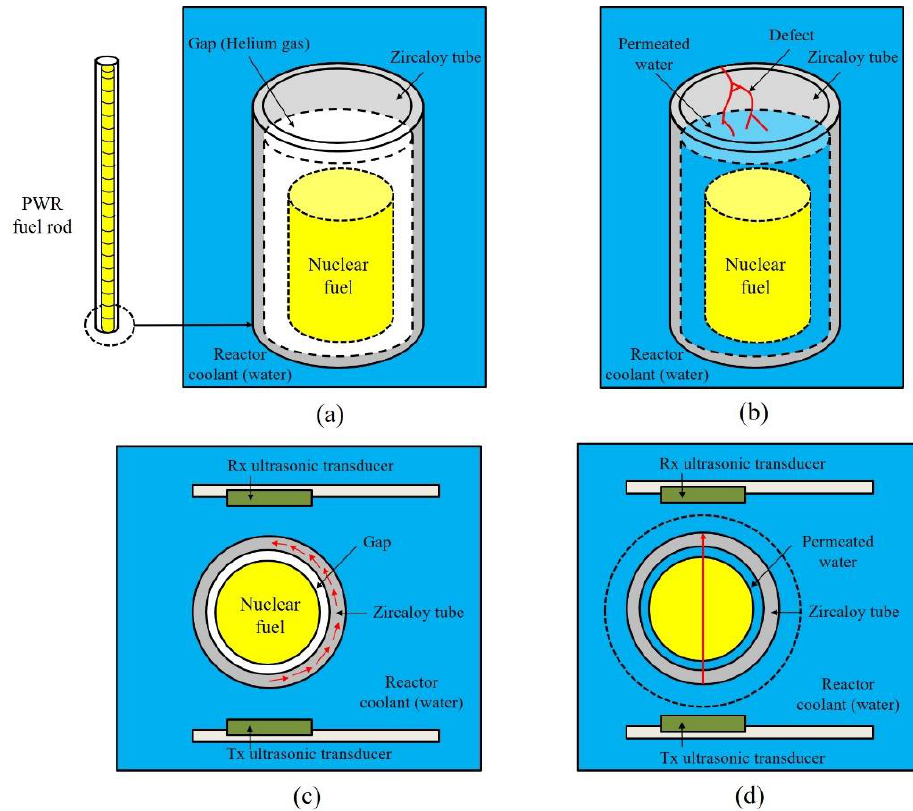
Figure 4. Conceptual diagram of sound and defective pressurized water reactor (PWR) fuel rods and its ultrasonic inspection: ( a ) Sound PWR fuel rod; ( b ) defective PWR fuel rod with permeated water from reactor coolant; ( c ) ultrasonic inspection of sound PWR fuel rod and its ultrasonic path, which is trapped in PWR fuel rod; ( d ) ultrasonic inspection of defective PWR fuel rod and through-transmitted ultrasonic path.